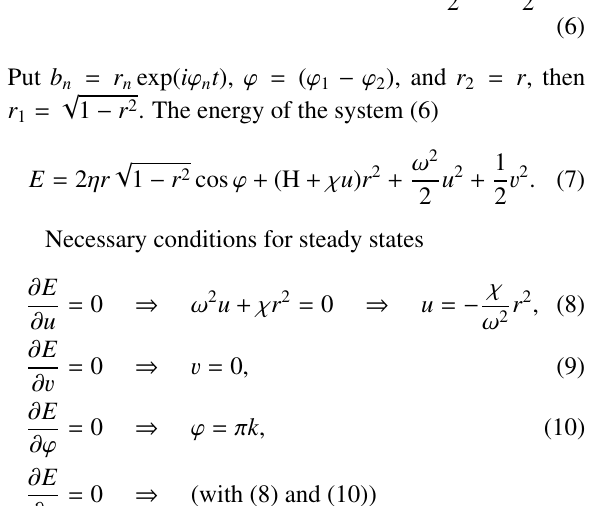
Figure 1. y = F ( r ) plots for various values of the electron energy H at the second site.